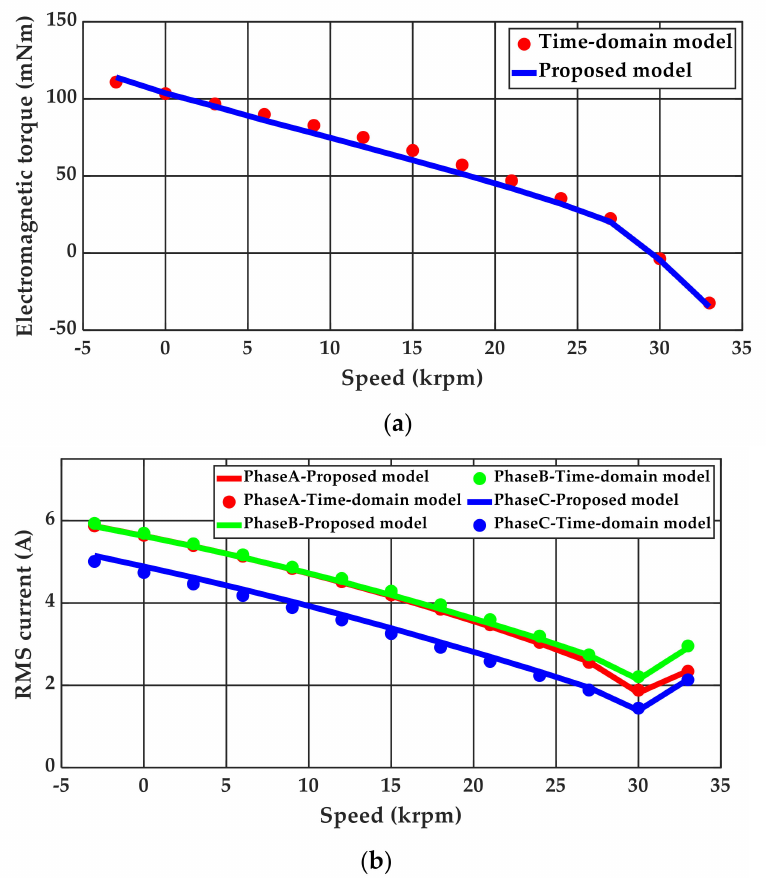
Figure 6. Results of computations for the square nonsymmetrical supplying waveforms: electromag- netic torque ( a ) RMS stator currents ( b ).